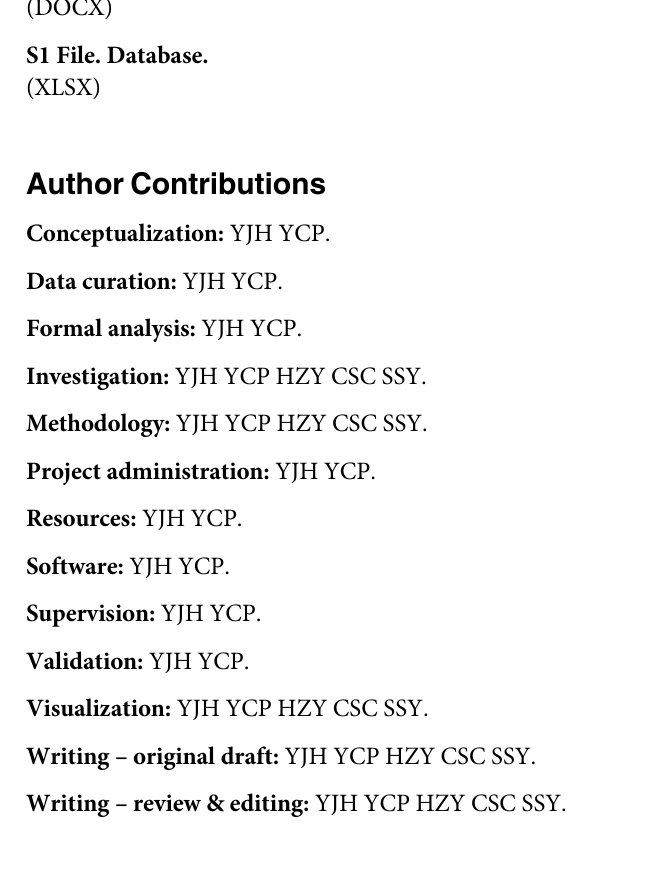
S1 Fig. Alignment of amino acid sequence of hepatitis B virus DNA in the patient with mutation. S1 Table. The result of mutations